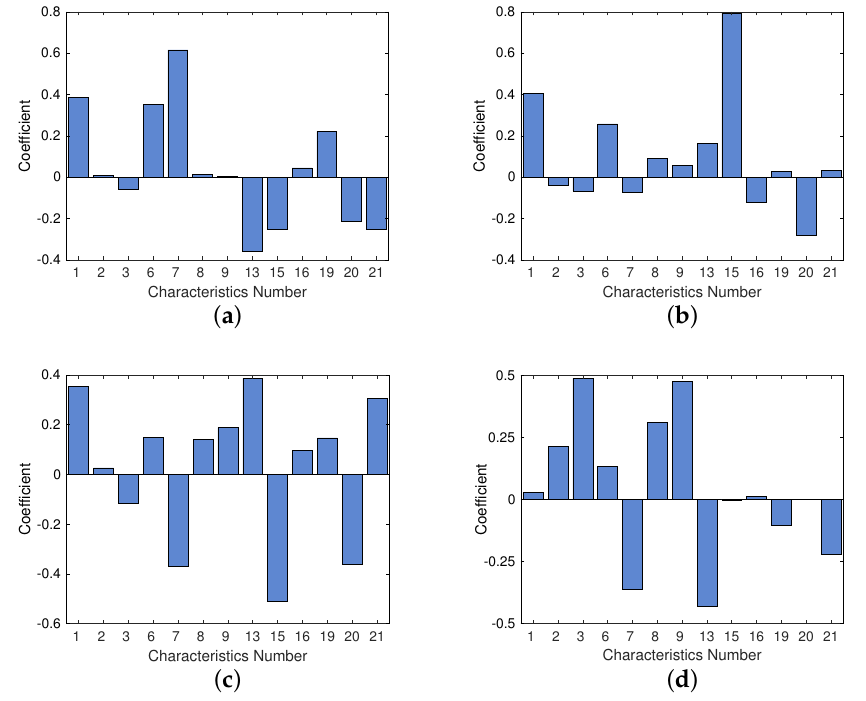
Figure 6. Linear combination coefficients of eigenvectors in the first four principal components: ( a ) coefficients of 1st principal component. ( b ) Coefficients of 2nd principal component. ( c ) Coefficients of 3rd principal component. ( d ) Coefficients of 4th principal